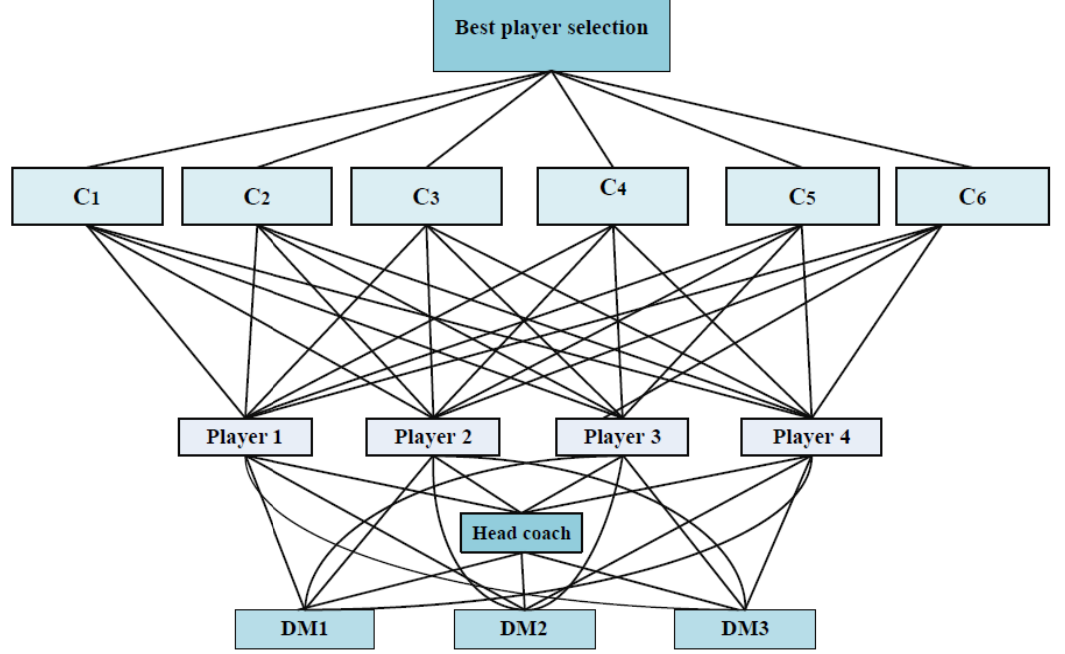
Fig.2 .the hierarchy structure of best player